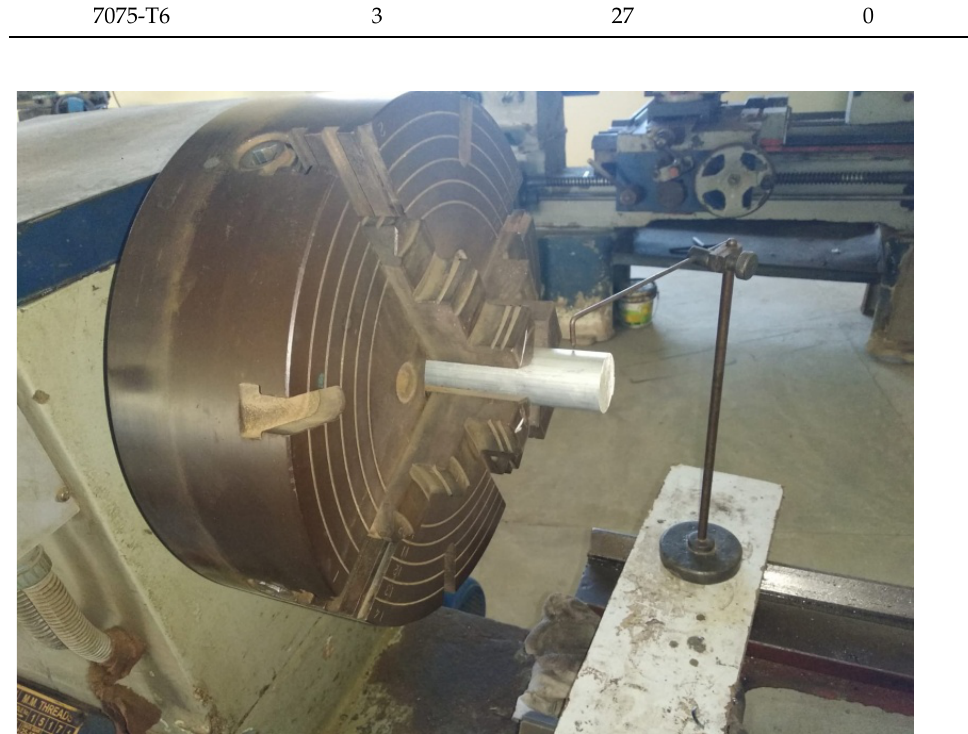
Figure 7. Centering of workpiece.